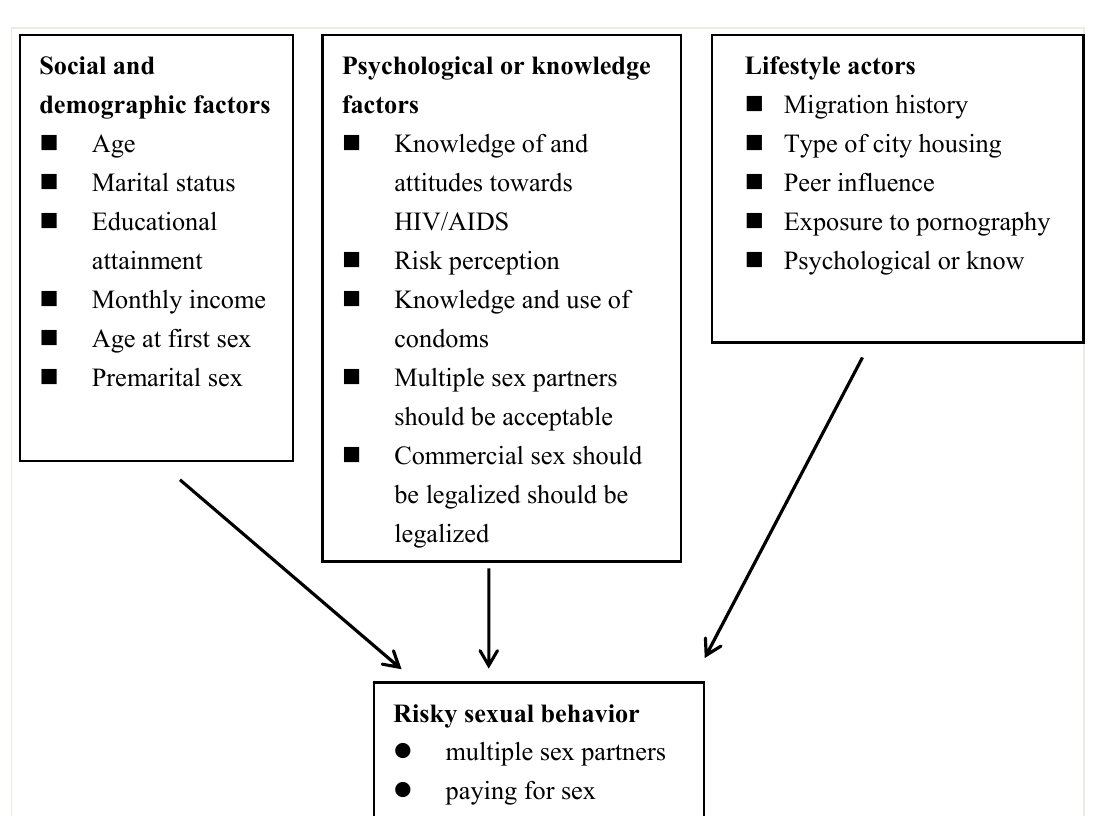
Figure 1. An theoretical framework for the study of male rural-to-urban migrants’ sexual behavior in Shanghai,